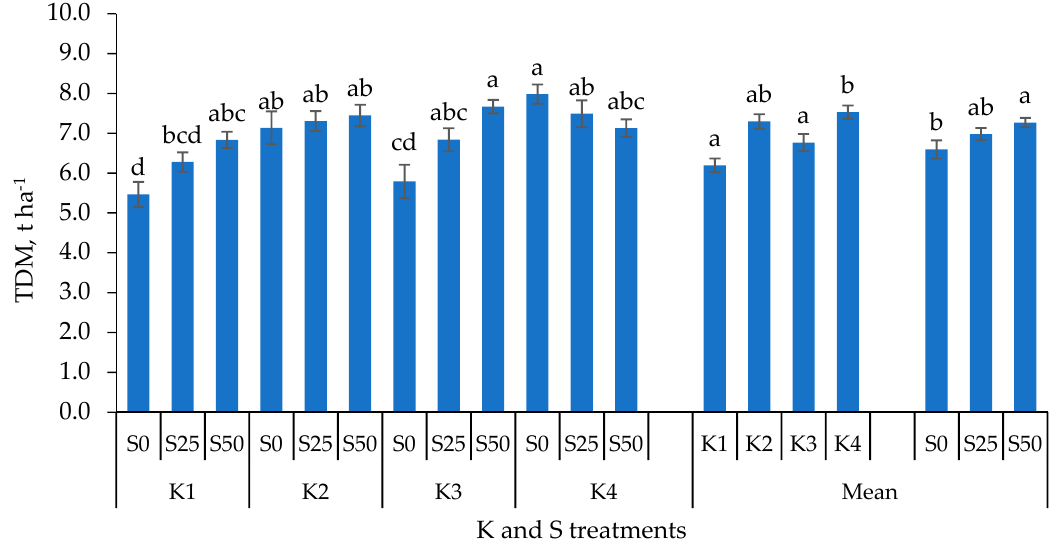
Figure 2. Effect of K treatments and S application on total dry matter (TDM) of faba bean. K1, K2, K3, and K4 refer to levels of soil K availability and fertilization; S0, S25, and S50 refer to sulfur application at rates of 0, 25, and 50 kg S ha − 1 , respectively. Means followed by the same letter are not statistically different ( p < 0.05). Hatched bars represent 2 × standard error (SE) ranges.